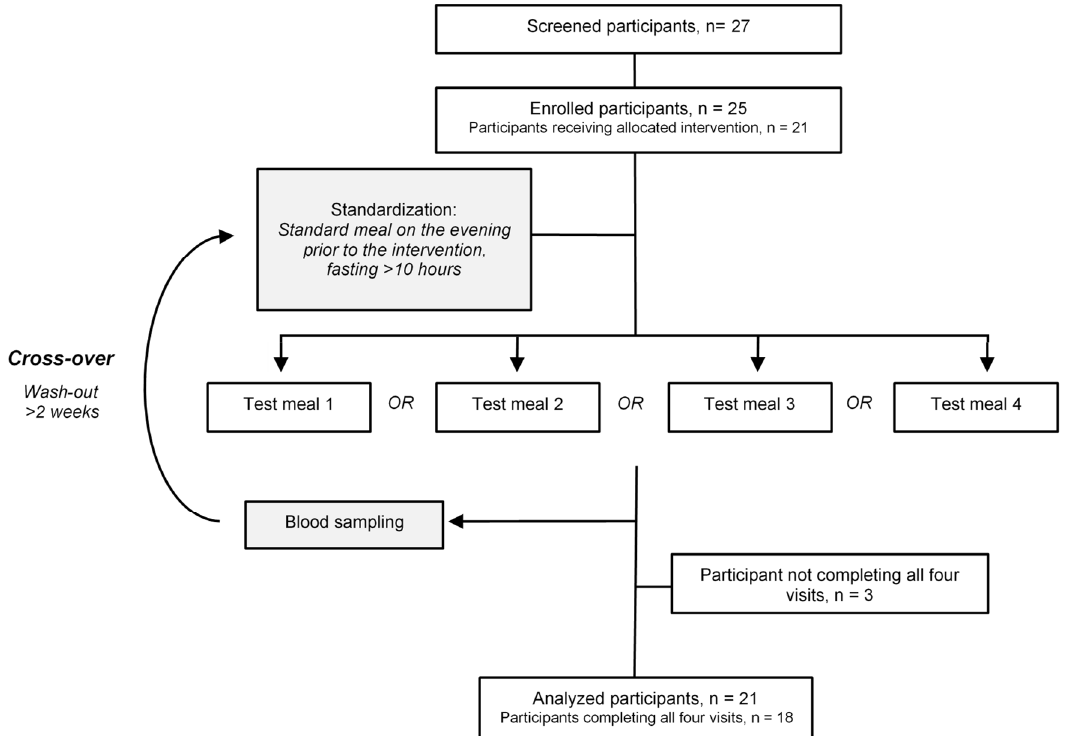
Figure 3. Study Figure 3. Study design.